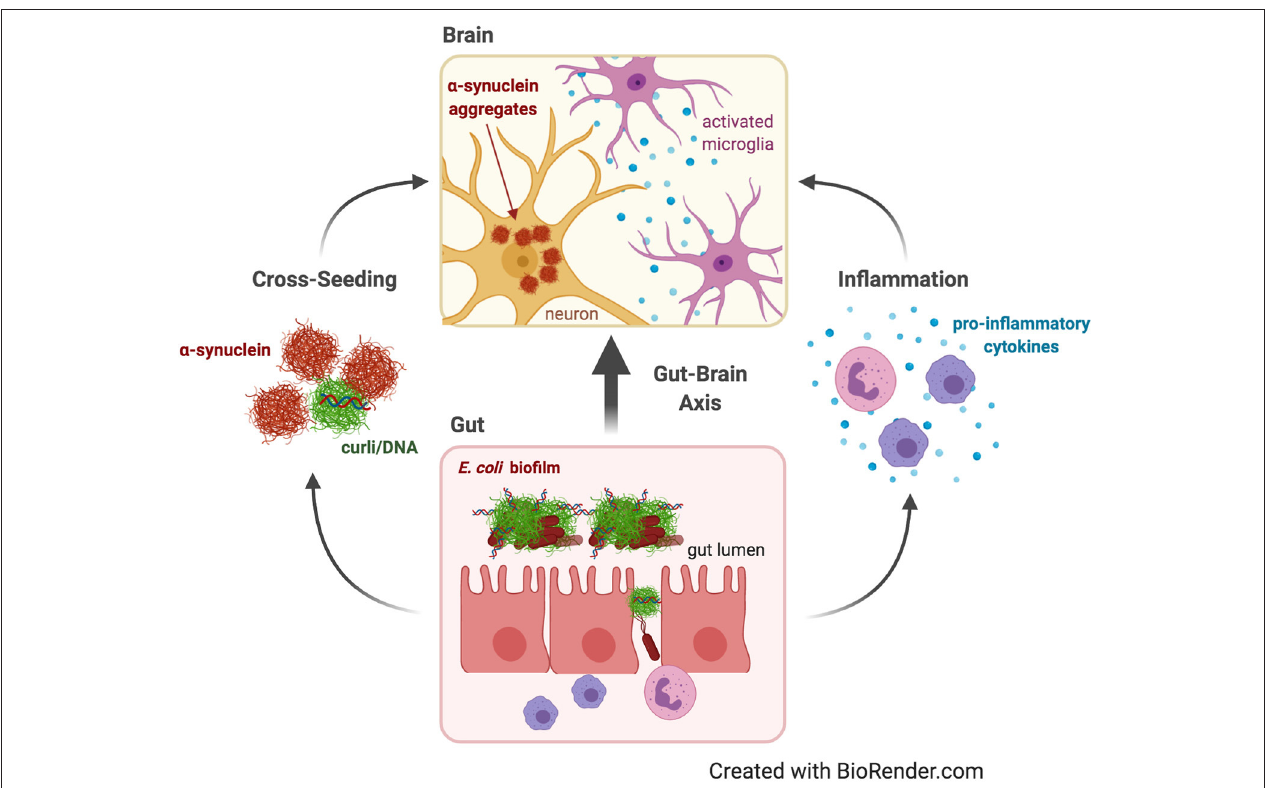
FIGURE 2 | Parkinson’s disease. Dysbiosis and leaky gut often occur with age, allowing contents of the gut lumen, such as curli from E. coli biofilms, to escape and induce changes in the brain through the gut-brain axis. Curli may contribute to Parkinson’s Disease by increasing systemic inflammation and neuroinflammation in the form of activated microglia and astrocytes and elevated pro-inflammatory cytokines. Curli may also cross-seed fibrillation and aggregation of α -synuclein, which is capable of prion-like propagation from the gut to the brain to cause